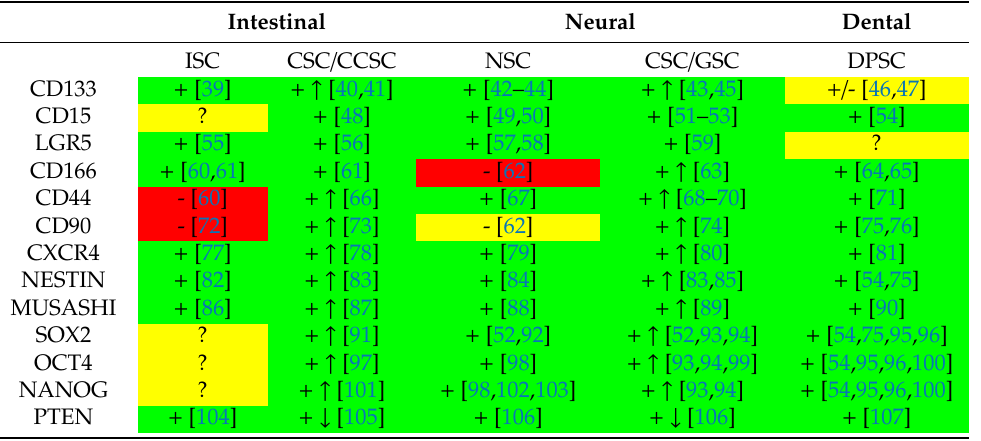
Table 1. Expression of cell markers and core factors involved in cancer in ISCs, NSCs and their corresponding CSCs, and DPSCs. Green color represents confirmed expression as reported by the literature. Red color represents absent expression as reported by the literature. Yellow color implies that its expression is not well defined or needs to be further studied. “ + ” symbol implies the existence of expression-confirming reports, “-” symbol implies the existence of no-expression supporting reports and question mark “?” implies that the expression of that marker has not been yet thoroughly assessed for a particular cell type. “ ↑ ” or “ ↓ ” symbol refers to an upregulation / increase or downregulation / reduction in its activity / expression with respect to their normal cell counterparts. ISC: intestinal stem cells. CCSC: colorectal cancer stem cells. NSC: neural stem cells. GSC: glioblastoma stem cells. DPSC: dental pulp stem cells. CSC: cancer stem